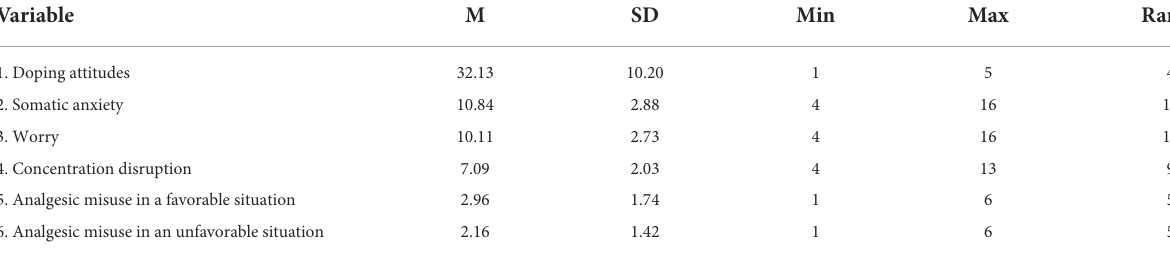
TABLE 1 Mean, SD, min, max and range of independent, and dependent variables. Variable